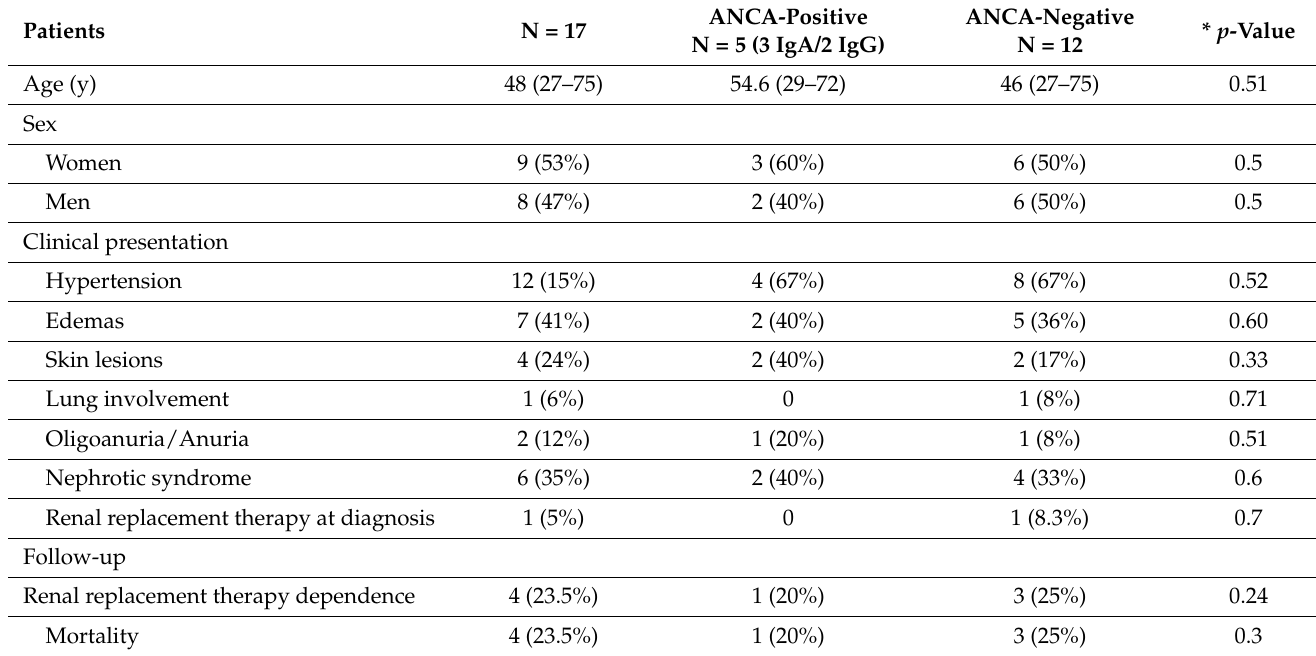
Table 1. Clinical characteristics of patients with crescentic IgA nephropathy according to the presence or absence of